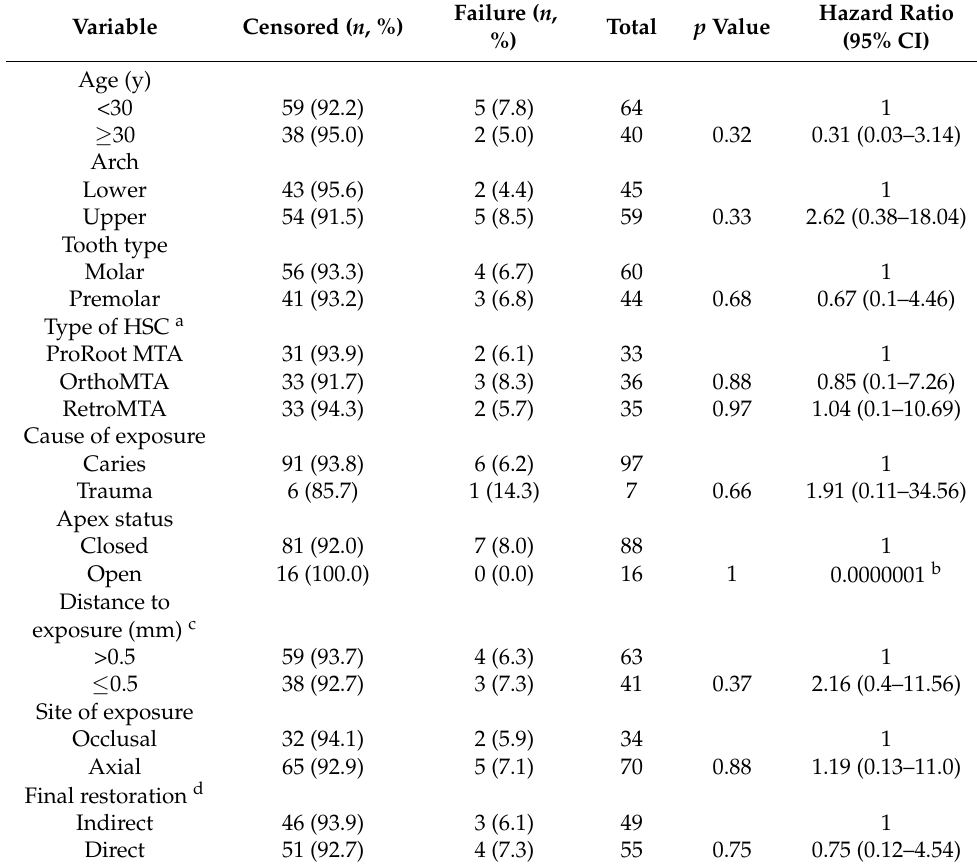
Table 3. Univariate Cox regression analysis according to the potential clinical variables ( n =